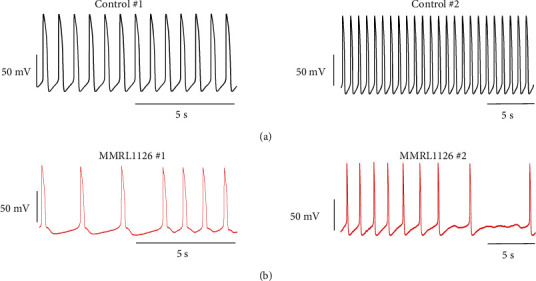
Action potential (AP) recordings obtained from WT and MMRL1126 monolayers. WT hiPSC-CMs were more hyperpolarized and had a larger Vmax. In addition, hiPSC-CMs from MMRL1127 exhibited slower spontaneous activity, and some showed episodic activity.